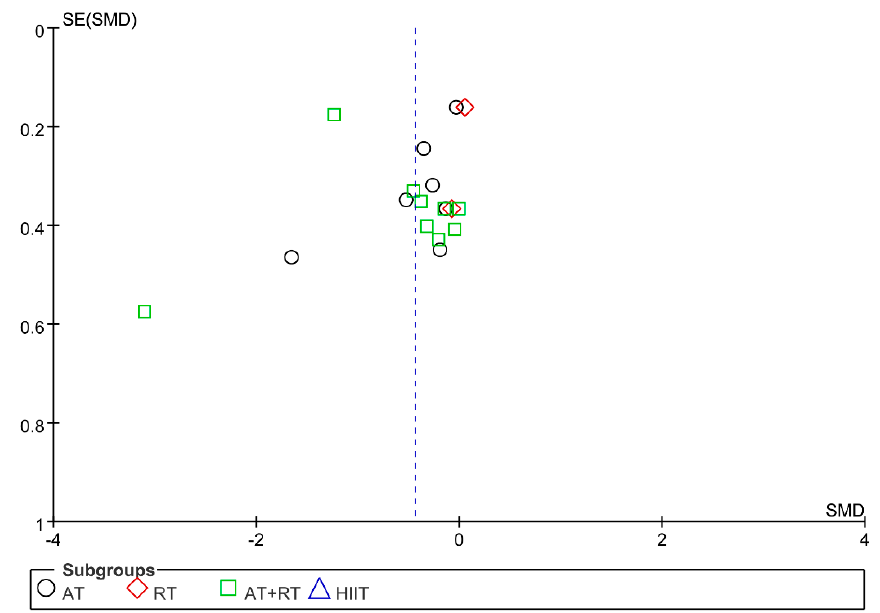
Figure 8. Publication bias of the influence of different training modalities on the level of CRP in adolescents with obesity.